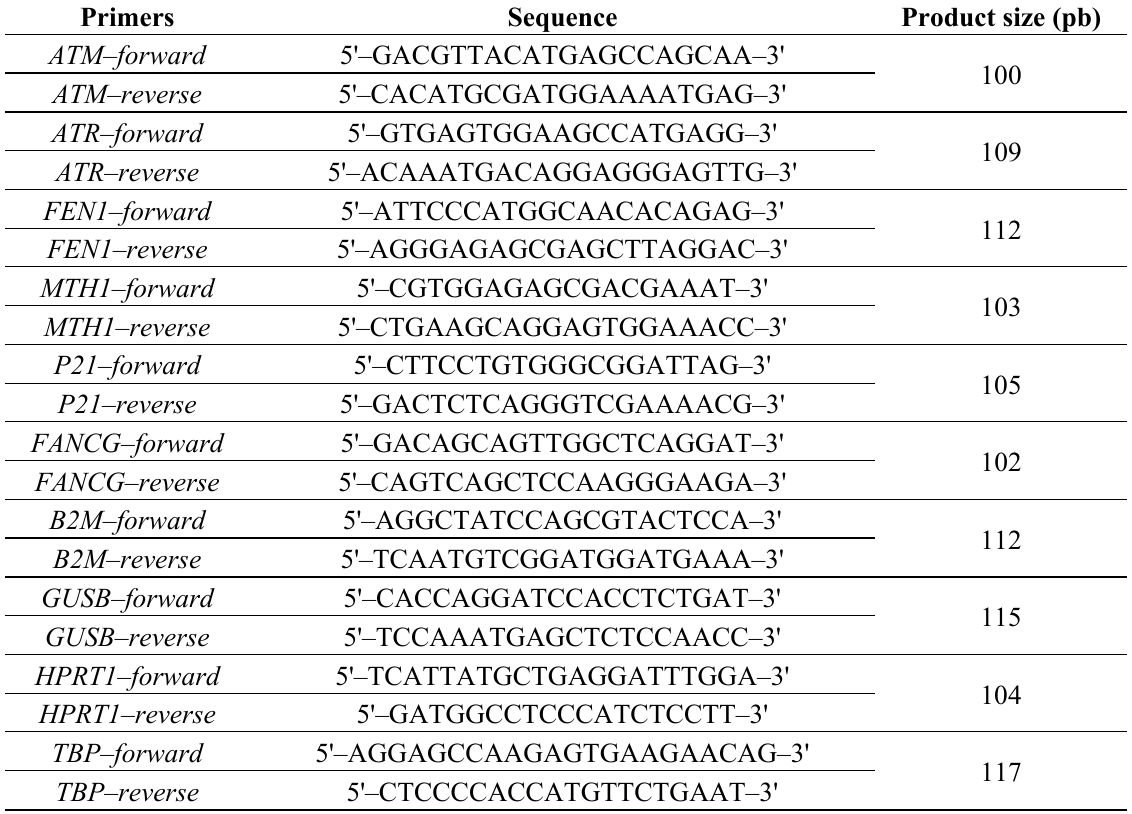
Table 3. Forward and reverse primer sets designed for genes analyzed by